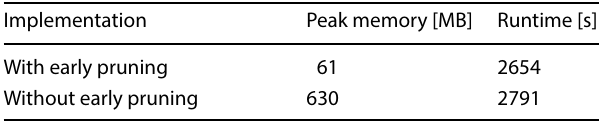
Table 5 The effect of the number of mock auditors